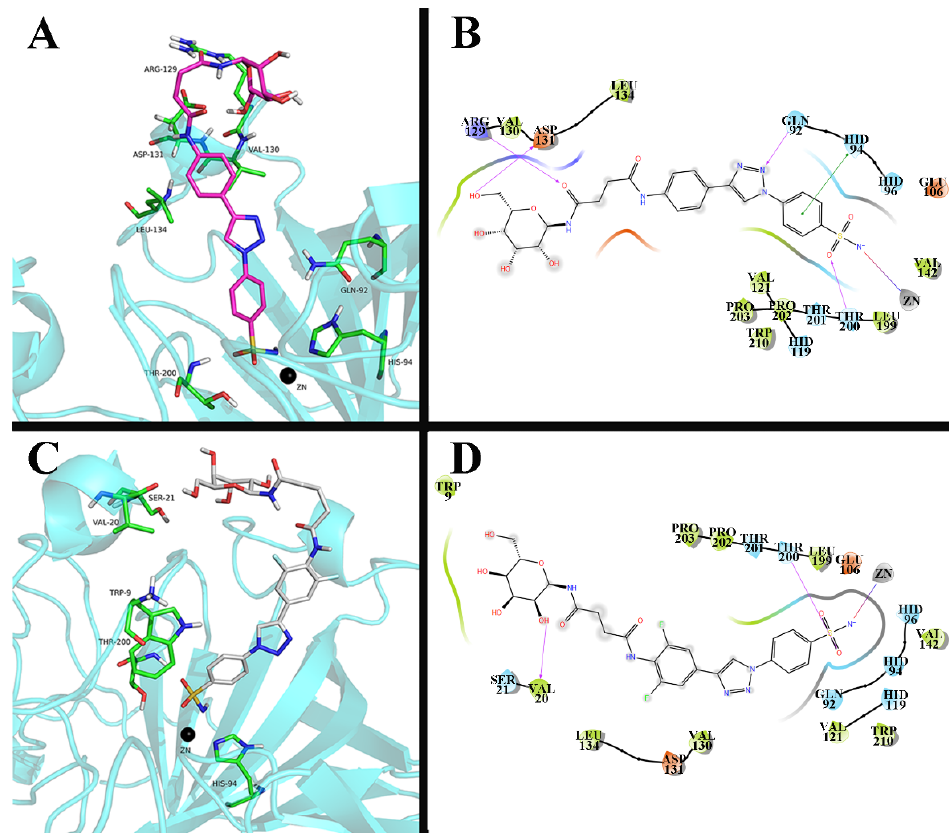
Figure 1. The modes of binding for compounds in h CA IX. ( A , B ). Compound 16a (pink). ( C , D ). Compound 16g (gray).